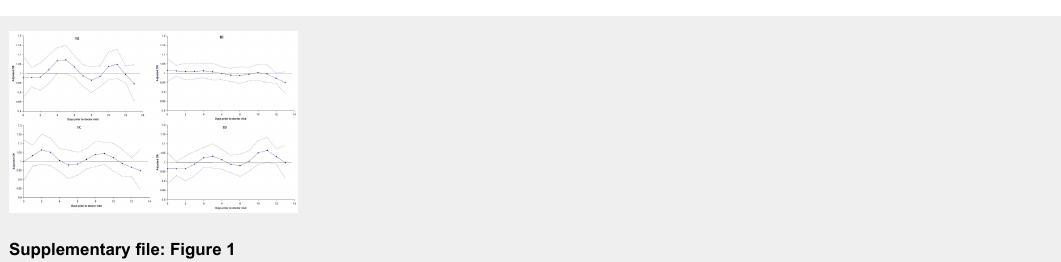
Adjusted OR’s for doctor visits for respiratory symptoms per 10 µg/m 3 increase in TSP at separate lags in subjects with asthma (A), chronic bronchitis (B), COPD (C), and subjects who are healthy (D) as estimated in conditional logistic regression. All models were adjusted for flu prevalence, polynomial distributed lags of T, RH, AP, T 2 , RH 2 , and T*RH from lag 0 – 6 days up to 2 degrees of freedom, and average T, RH, AP, and T 2 from lag 7 – 13